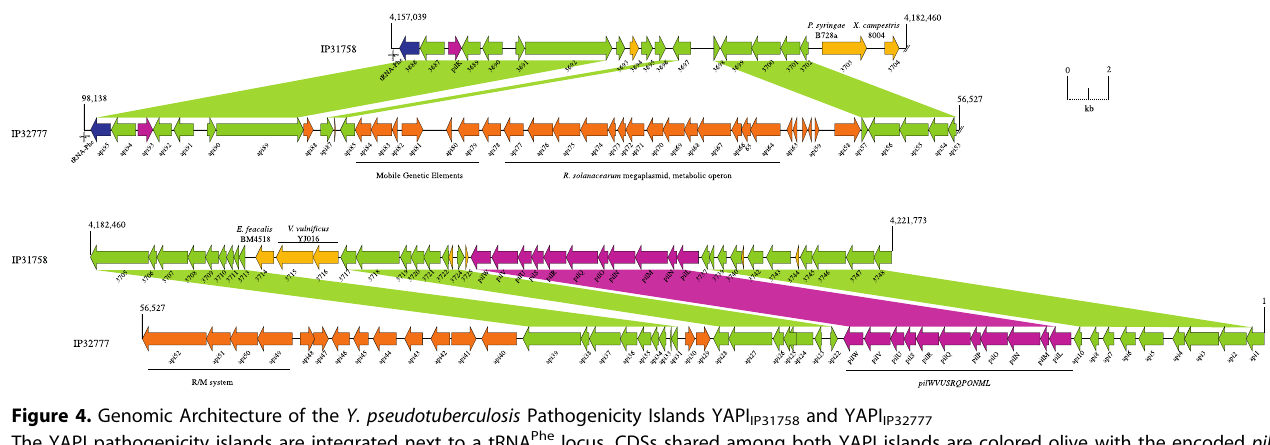
Figure 4. Genomic Architecture of the Y. pseudotuberculosis Pathogenicity Islands YAPI IP31758 and YAPI IP32777 The YAPI pathogenicity islands are integrated next to a tRNA Phe locus. CDSs shared among both YAPI islands are colored olive with the encoded pil (pilin) gene cluster highlighted in magenta, strain-specific CDSs are colored in yellow and orange, and the YAPI-specific phage integrase is colored in blue. The coordinates of the Y. pseudotuberculosis IP32777 are according to [44].